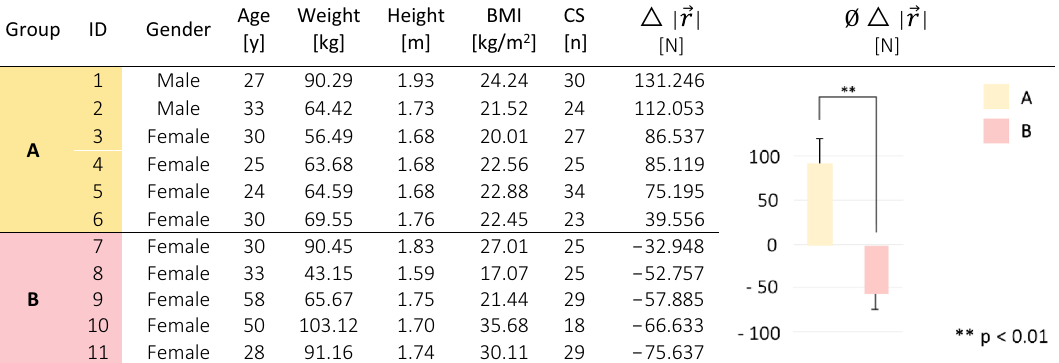
Table 1. Demographic data, physical characteristics, and group classification of the study participants. BMI = body mass index. CS = chair squat. The deviation ( △ ) between the maximum peak of the resultant